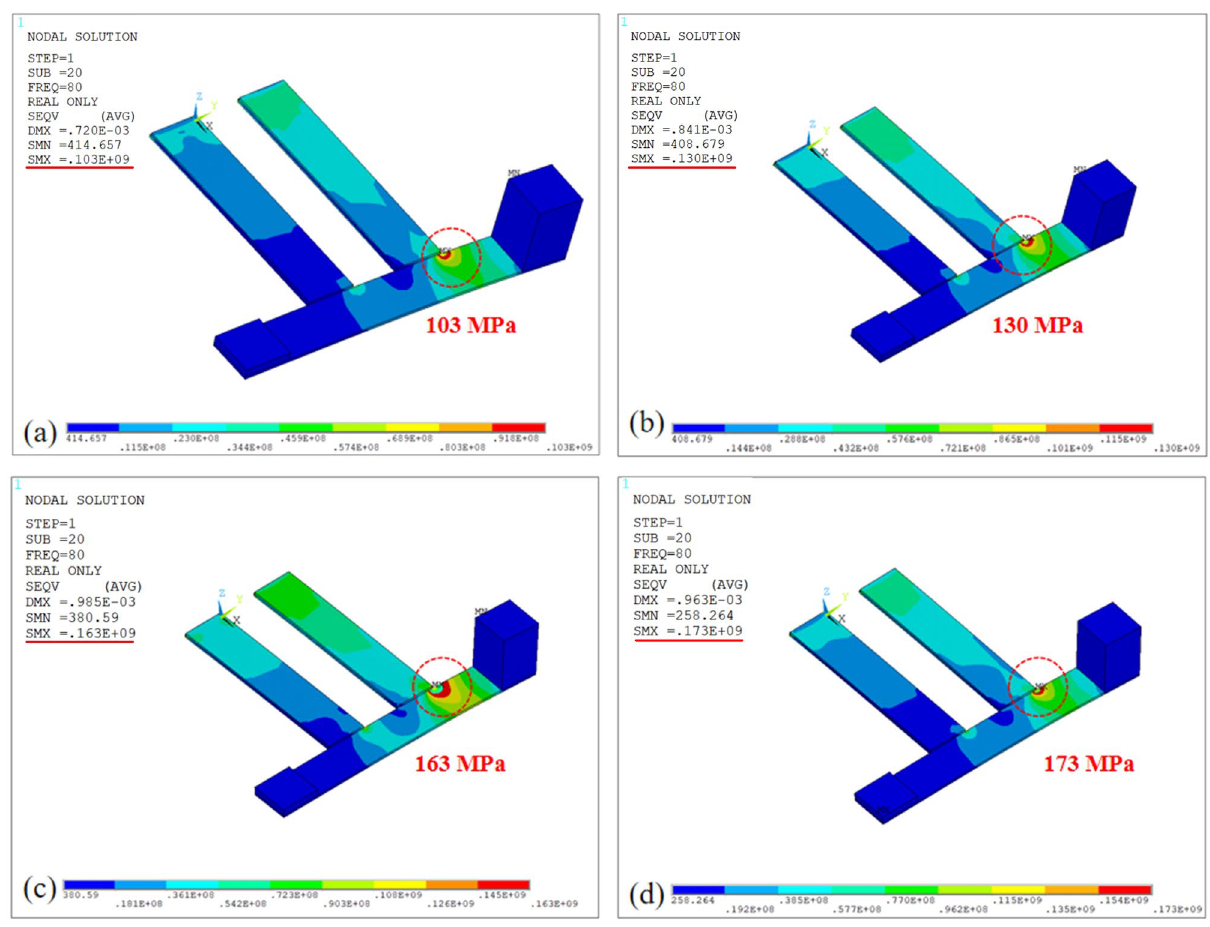
Figure 2. The modal stress diagrams of convergent judge at the mesh densities for PEHDCB ( a ) 0.7, ( b ) 0.6, ( c ) 0.5 and ( d ) 0.4